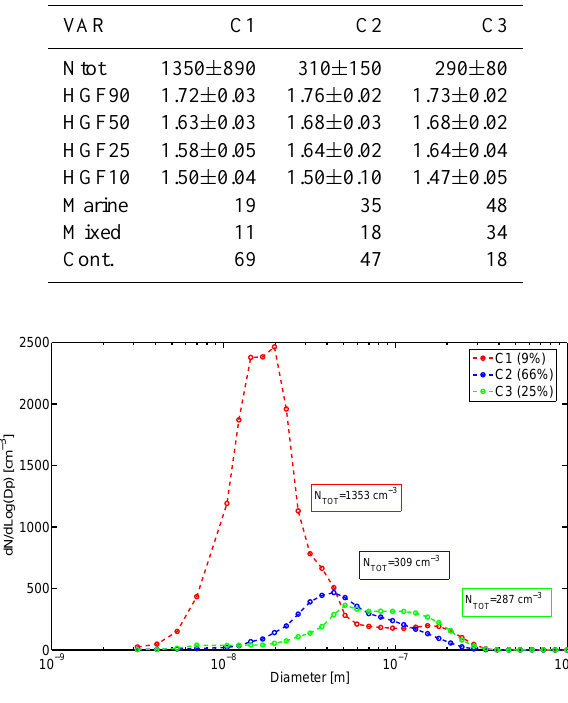
Table 3. Variables (VAR) of particle total number ( N tot ), hygro- scopic growth factors (HGF) and air mass origin corresponding to particle number size distributions grouped into three clusters (C1, C2, C3) presented in Fig. 7. Average and standard deviation of total particle number [cm − 3 ] and HGF of 90, 50, 25 and 10nm particles are presented for each cluster type. Additionally, the influence of marine, mixed and continental air masses are shown in [%]. The air masses were devided based on the lowest (10 m) trajectory propaga- tion time from the ocean using boundaries < 24h (marine), 24–72h (mixed), and > 72h (continental).